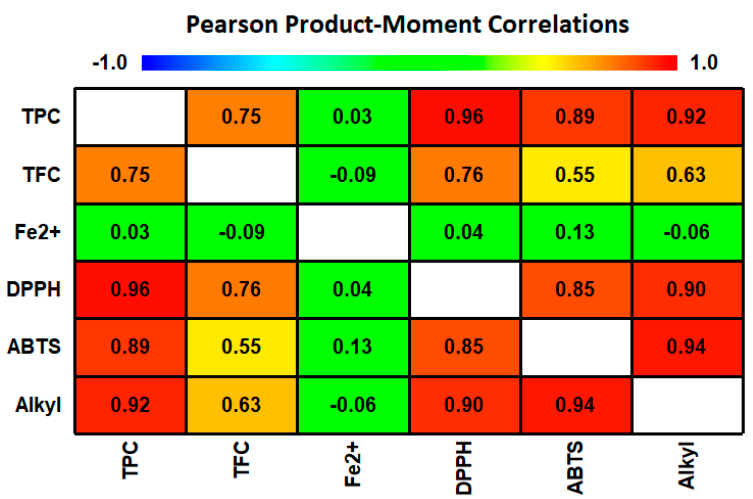
Figure 4. Correlations between the phenolic contents and antioxidant activities of TB teas. TPC, total polyphenol content; TFC, total flavonoid content.